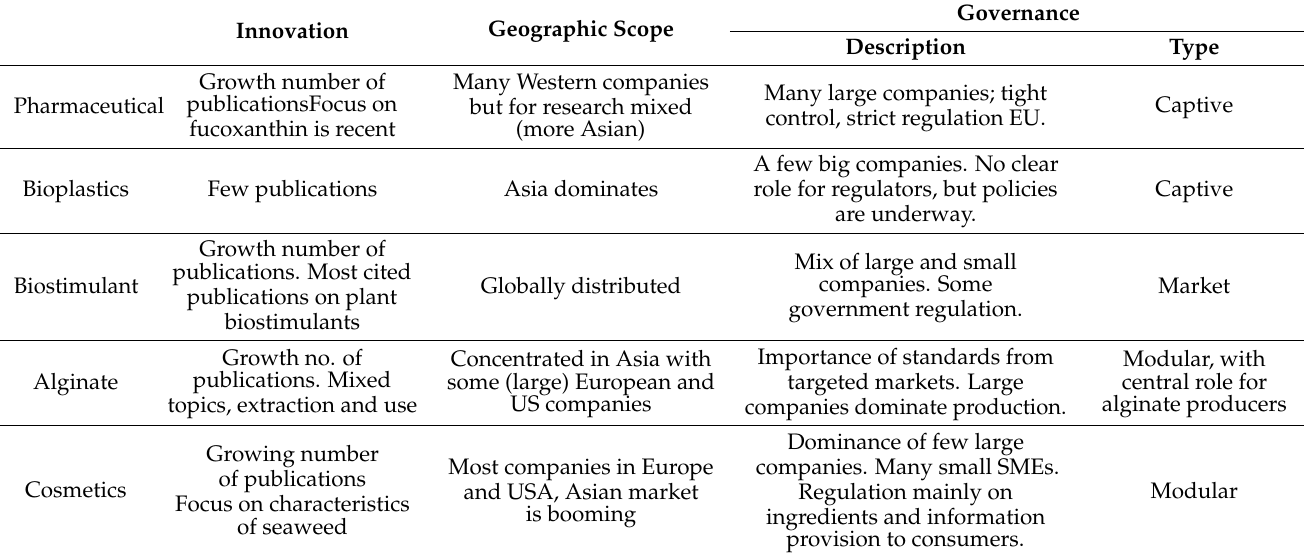
Table 2. Summary of the value chain